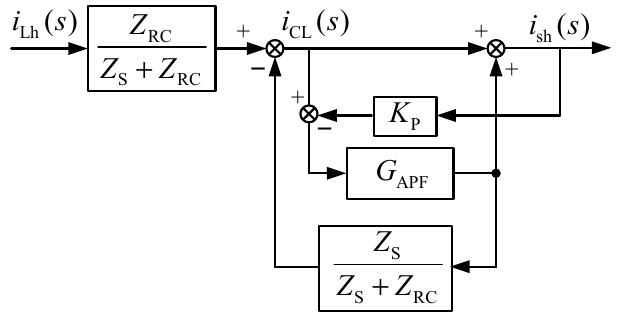
Figure 10. Block diagram of the compound control system.